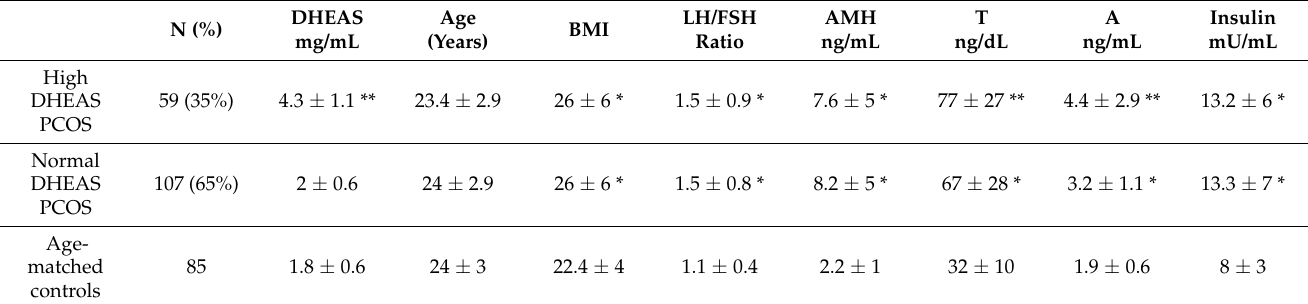
Table 1. Some clinical and hormonal data in 648 young women with polycystic ovary syndrome (PCOS), aged 20 to 29 years, divided into normal or high (>3 mcg/mL) DHEAS serum values.